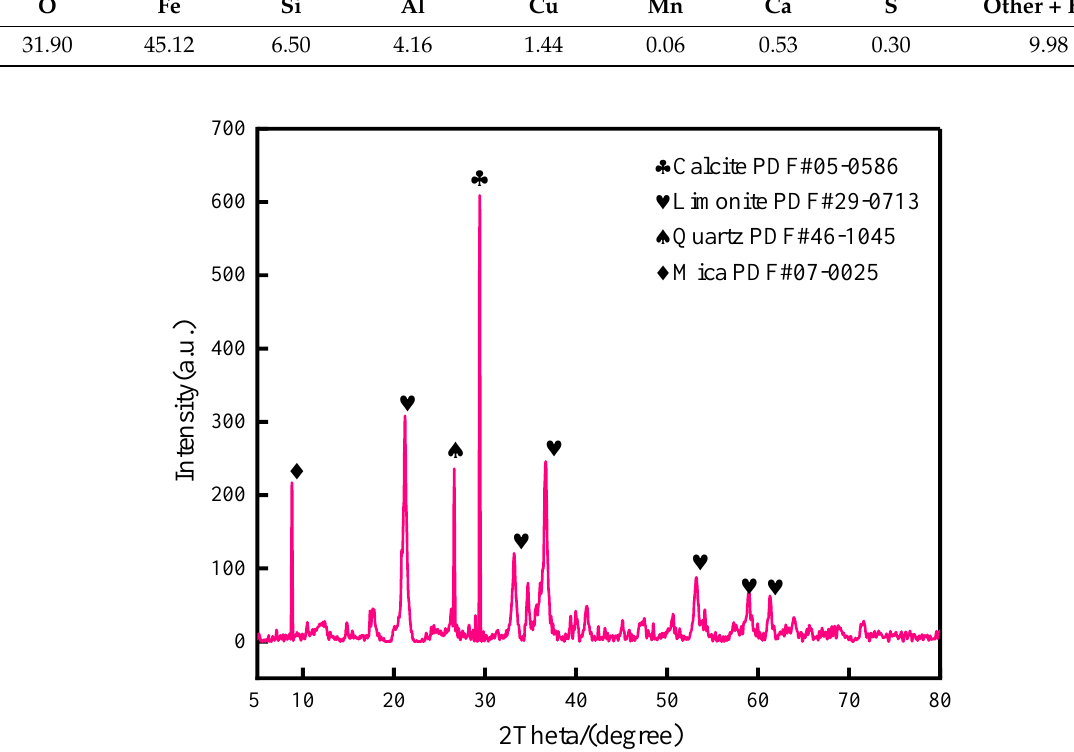
Table 1. Chemical composition analysis of the COBL ore (wt%).